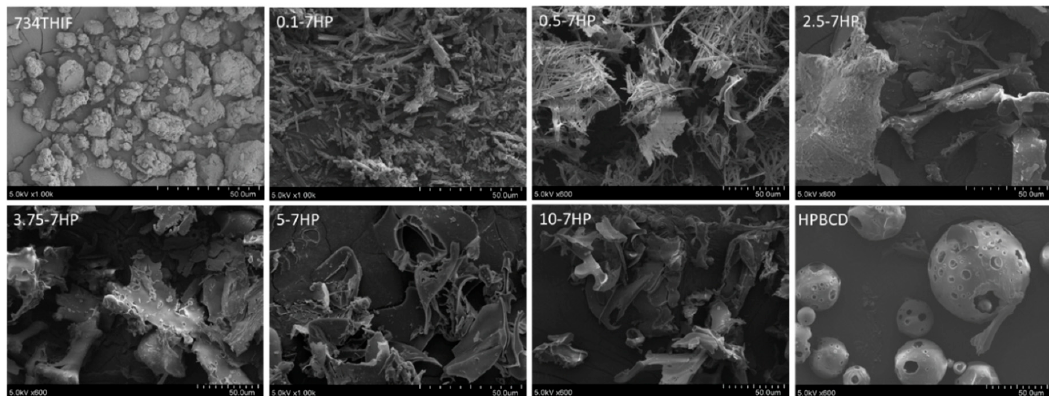
Figure 2. The surface morphology of 734THIF, HPBCD and 7HPs was observed by scanning electron microscopy (SEM).